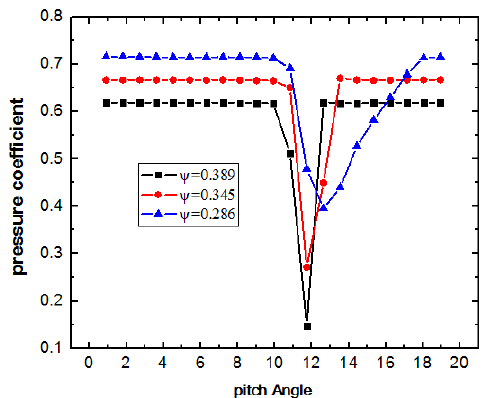
ff erent mass-flow coe ffi cients.